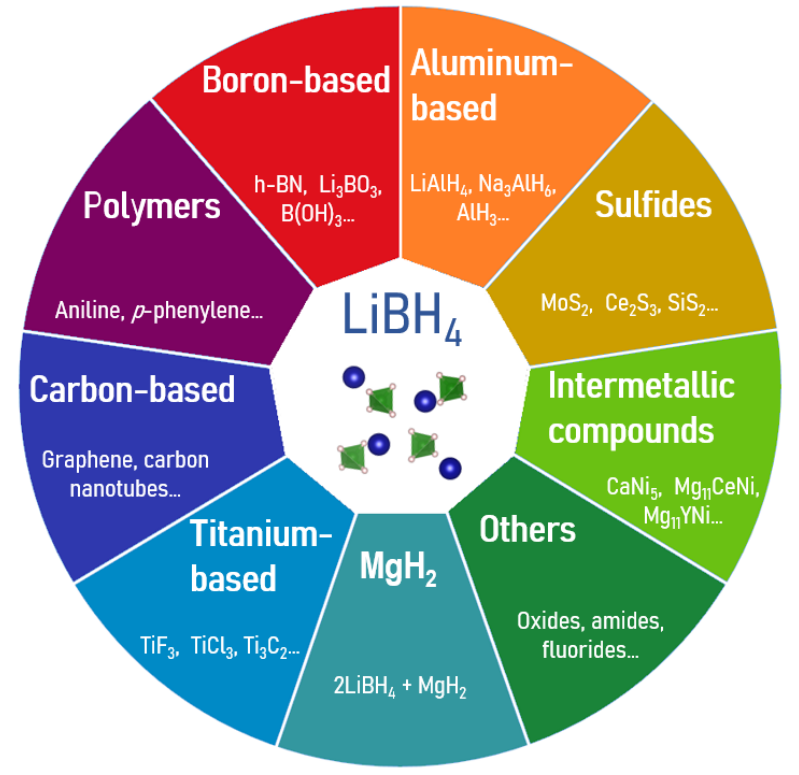
Figure 6. Categories and some examples of the additives used to destabilize LiBH 4 in the solid